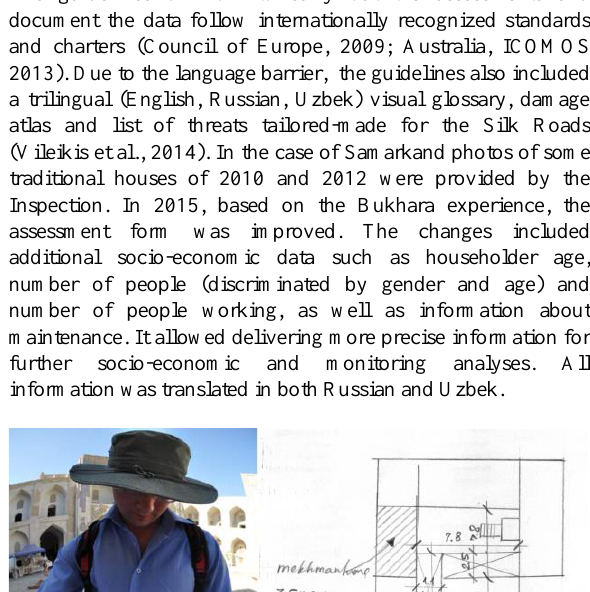
Figure 8. Itchan Kala GIS in ArcGIS 9.3. Depicting monuments, city blocks, surveyed dwellings and World